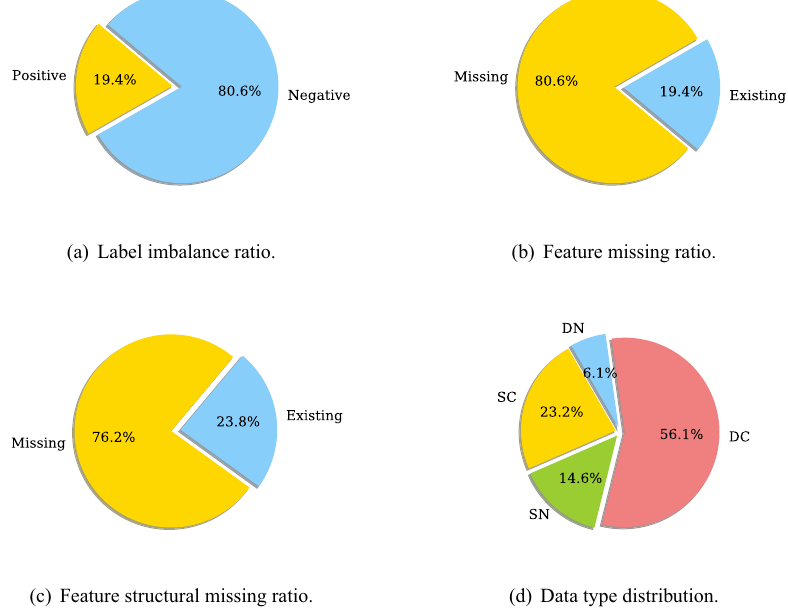
Figure 7. Data characteristics of the enterprise data from a bank. SC static categorical data, SN static numerical data, DC dynamic categorical data, DN to dynamic numerical data.